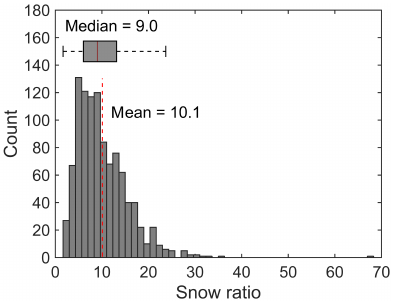
Figure 4. Distribution of snow ratios, ratio of snow depth change to LWE, calculated from retrieved ensemble mean densities with interquartile range, and median and mean